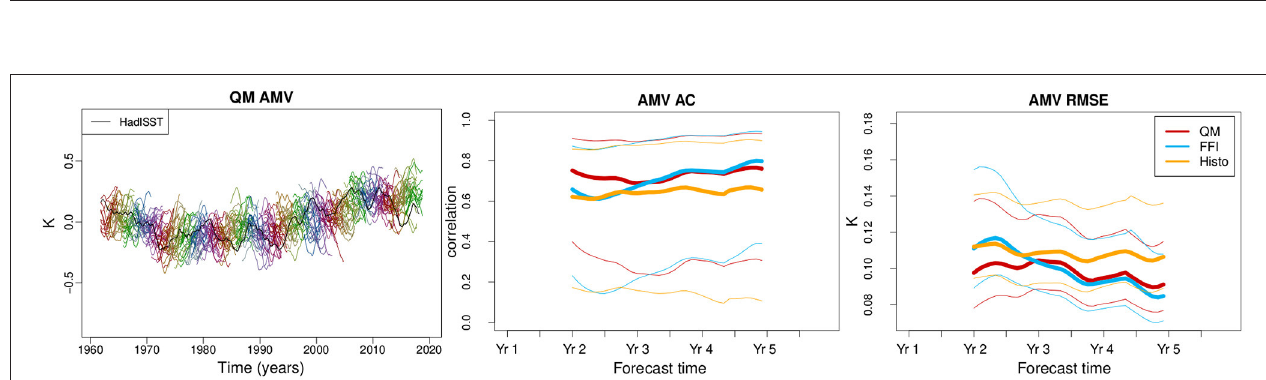
FIGURE 10 | Atlantic multidecadal variability (AMV) index for the quantile matching (QM) predictions (left) . The index computed from HadISST is shown in black. The different colors represent the different start dates. The anomaly correlation (AC) and the root mean square error (RMSE) of the AMV index are shown, respectively, in the central and right panels. The skill scores are calculated against the HadISST dataset, applying a 2-year running mean to the data. As in previous figures, the thin lines represent the 95% confidence interval obtained with a t-distribution for the correlation and a χ 2 distribution for the RMSE.